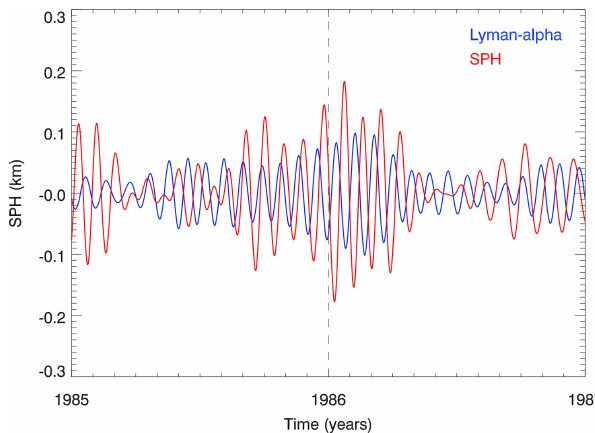
Figure 7. Same as Fig. 6 but from 1985 to